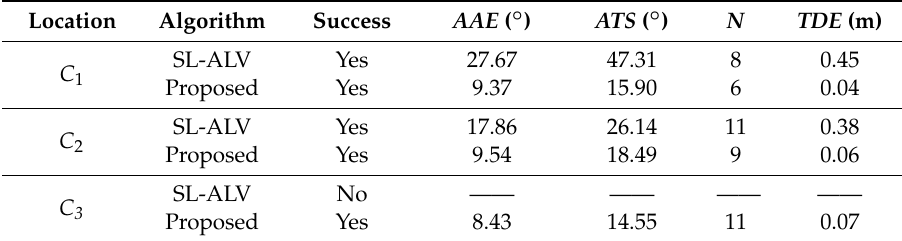
Table 5. Associated results of homing experiment 2.